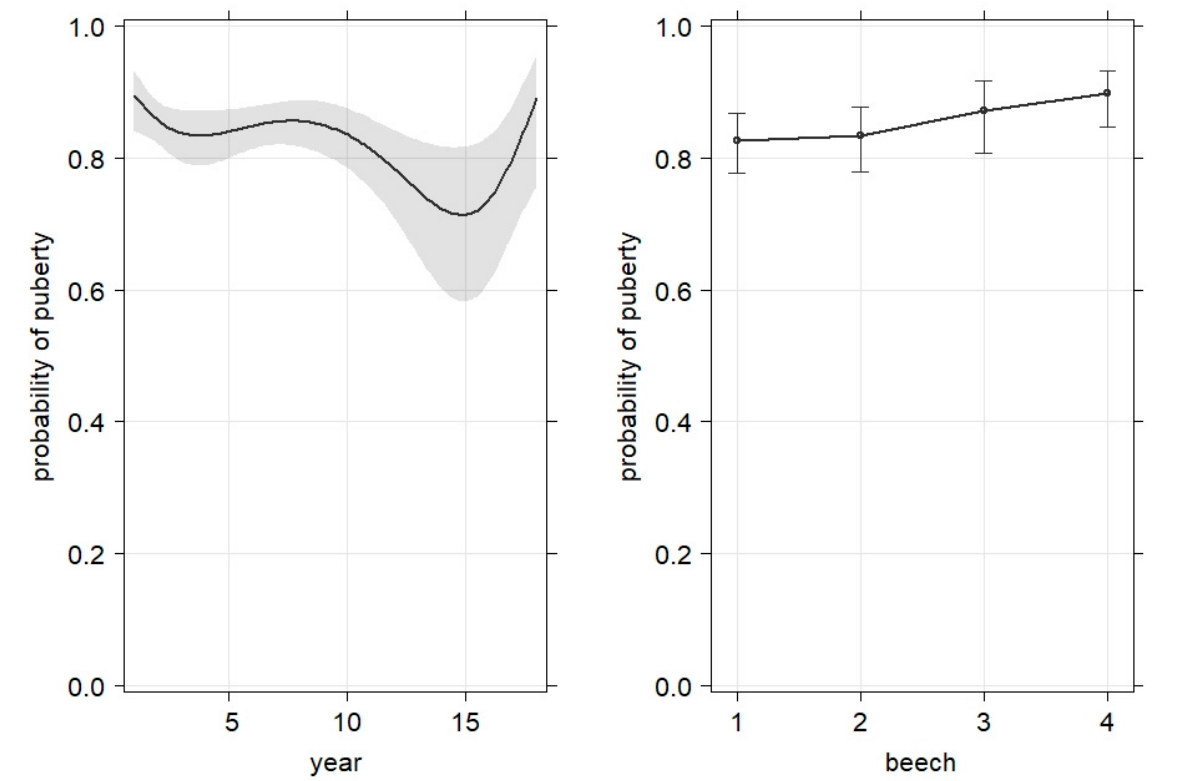
Figure 6. Probability of puberty slightly decreased with increasing overall bw over years ( left ) and slightly increased with beech mast ( right ; numbers represent levels according to categorization from forestry commission office Oerrel, Lower Saxony; 1 = no, 2 = part, 3 = half, 4 = full mast).